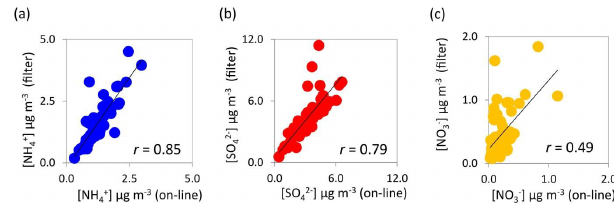
Fig. 6. Comparisons of on-line continuous particle analyzer data Figure 6. Comparisons of on-line continuous particle analyzer data and filter-based IC 686 measurements: (a) NH 4+ , (b) SO 42- , (c) NO 3- . 687